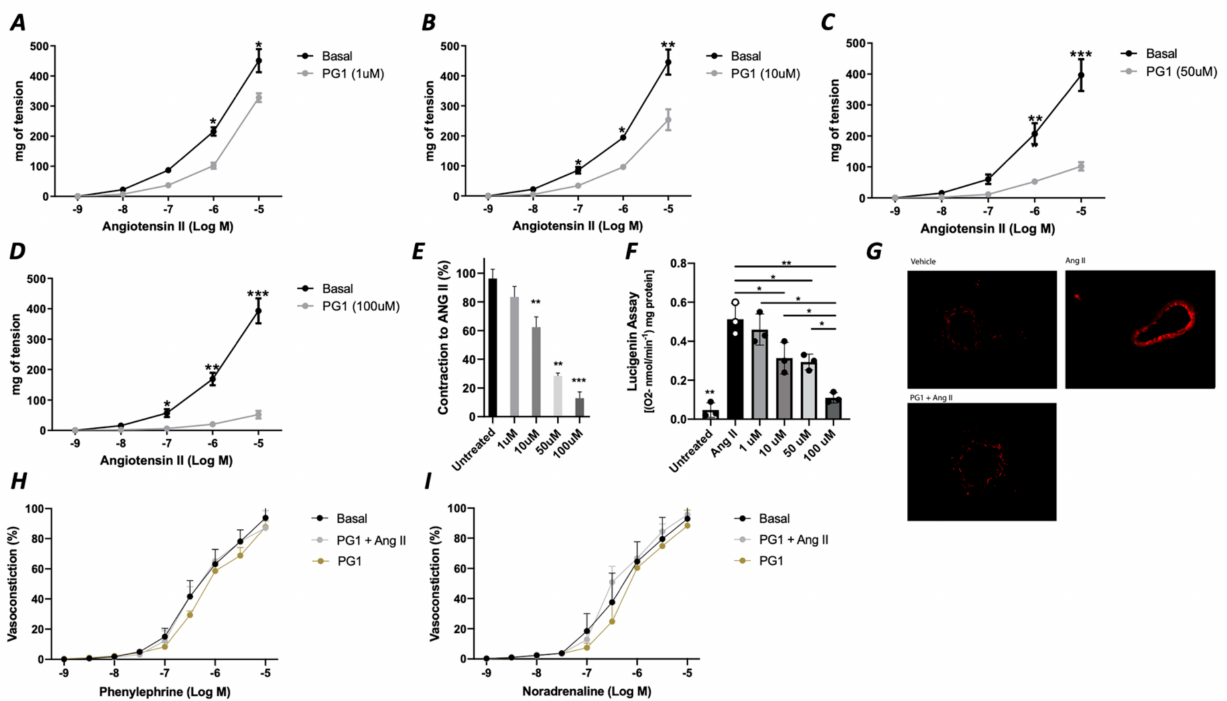
Figure 2. ( A – D ) Effects of PG1 at different doses 1 µ M ( A ), 10 µ M ( B ), 50 ( C ) and 100 µ M ( D ) on angiotensin II-evoked vasoconstriction in mice mesenteric arteries compared to vehicle treated alone. ( E ) Percentage of reduction of vasoconstric- tion at different dosage of PG1 (1, 10, 50 and 100 µ M). ( F ) Oxidative stress measured by lucigenin assay on vessels treated with Angiotensin II alone, or ore-incubated with PG1 for 1 h at different doses 1, 10, 50 and 100 µ M before Angiotensin II stimulation (10 − 5 ). ( G ) Representative micrographs of Dihydroetidium staining in mesenteric arteries treated with vehicle, with angiotensin-II (10 − 5 ) for 30 min of with PG1 (100 µ M) plus Angiotensin II. H-I) Vasoconstrictive responses to increasing doses of ( H ) phenylephrine or ( I ) noradrenaline, respectively, in basal condition (without stimuli), after PG1 (100 µ M) pretreatment, and after pretreatment with PG1 (100 µ M) plus Ang II (10 − 7 M). *, p < 0.05; **, p < 0.001; ***, p <